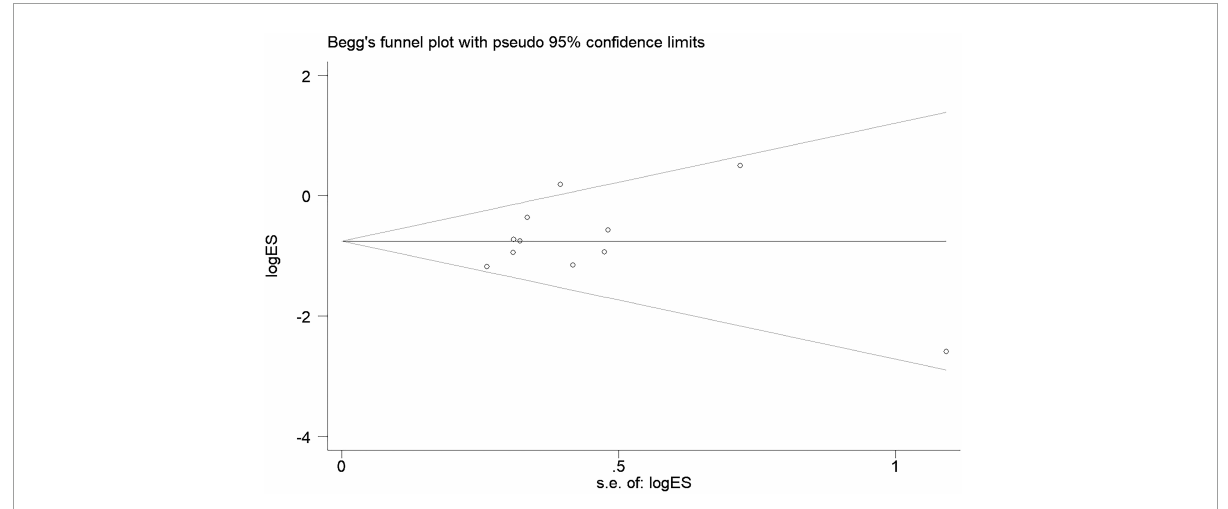
FIGURE6 Begg’s funnel plot for the publication bias. Shape of the funnel plot showed no obvious asymmetry. Besides, both Egger’s test ( p = 0.764) and Begg’s test ( p = 0.436) showed that no significant publication bias